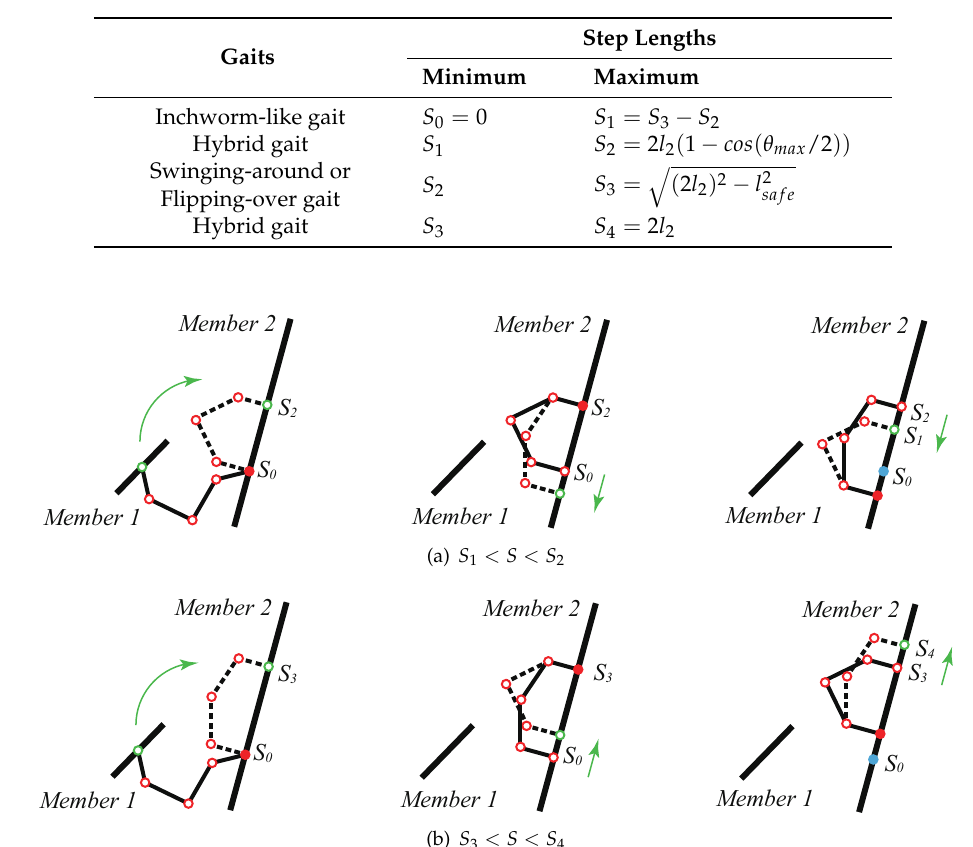
Table 1. Minimum and maximum step lengths with different gaits.